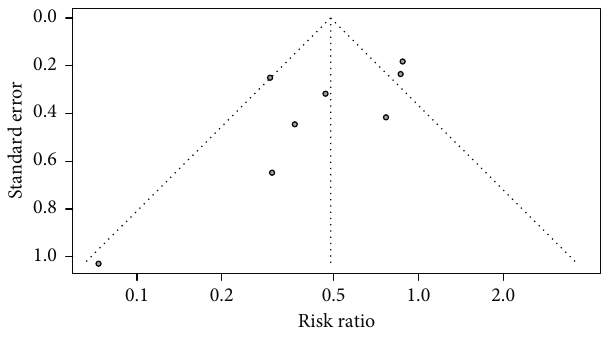
0.1 Figure 4: Funnel plot for publication